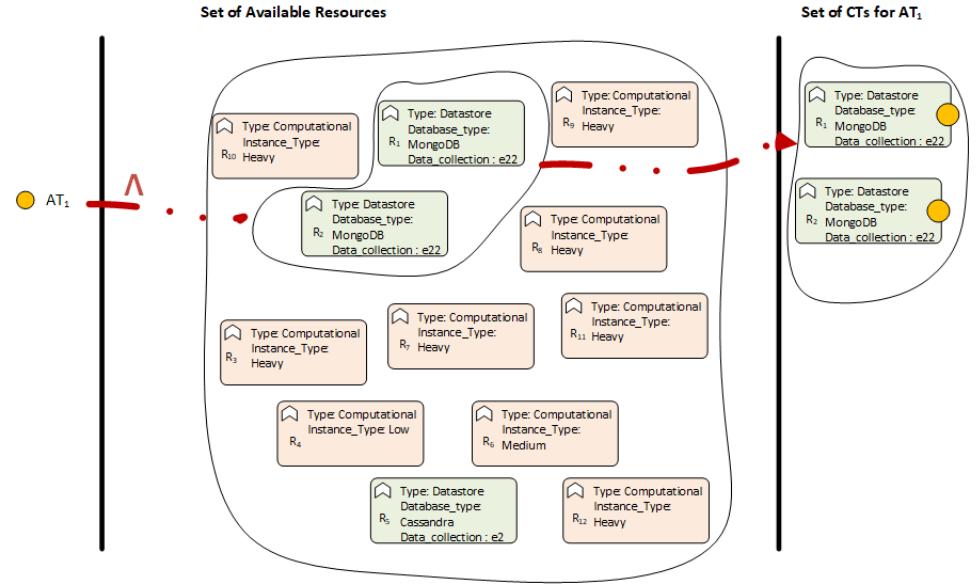
Figure 9. Resource Allocation Process based on the equivalence relation Λ , where for the AT 1 , a list of CT s, is created, assigning that Abstract Task to the resources R 1 and R 2